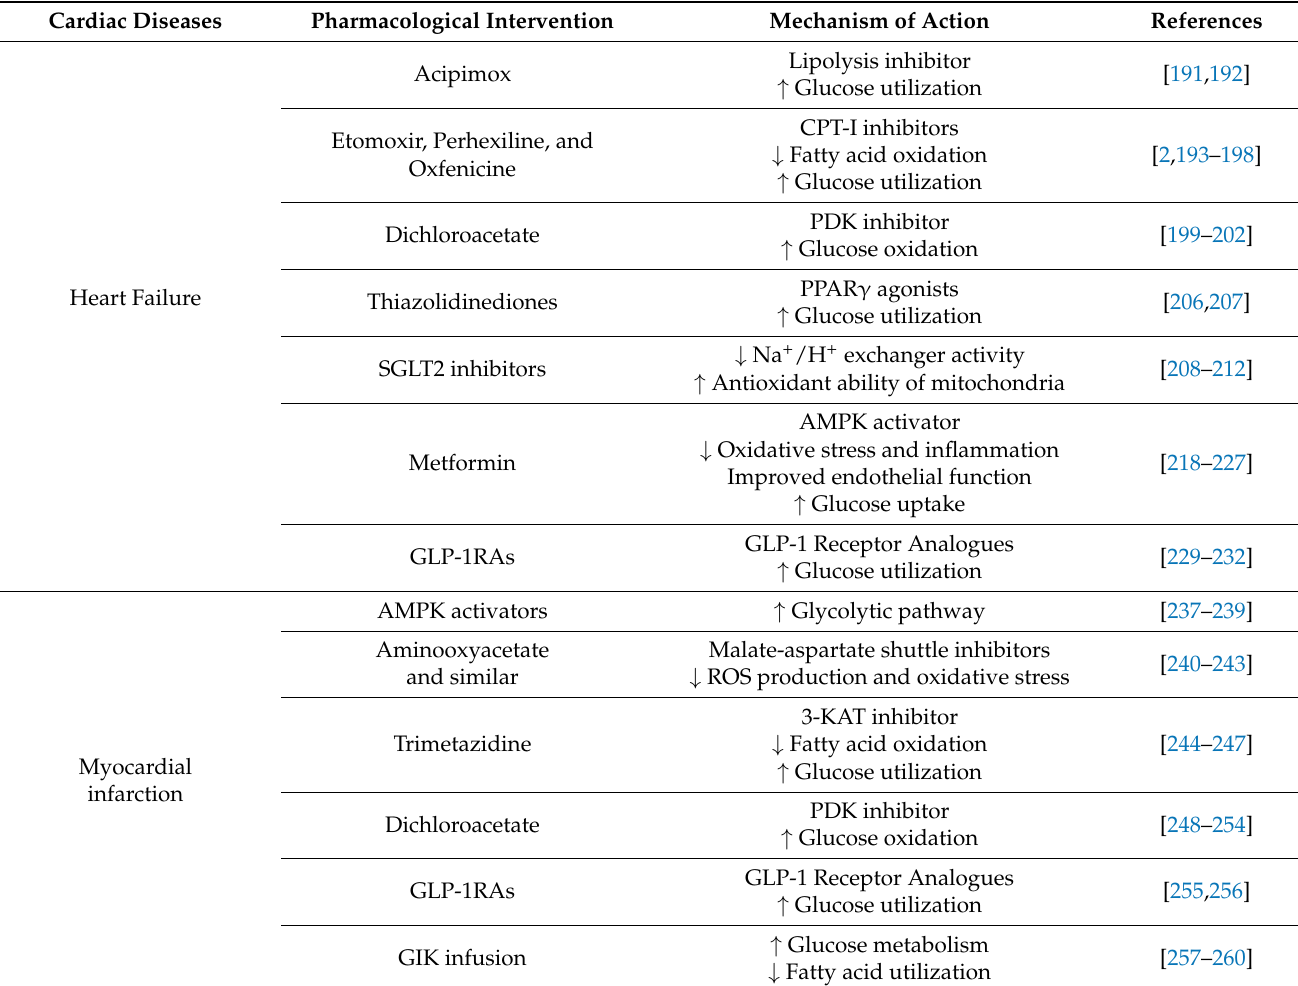
Table 3. Metabolic pharmacological intervention in heart failure and myocardial infarction. Cardiac